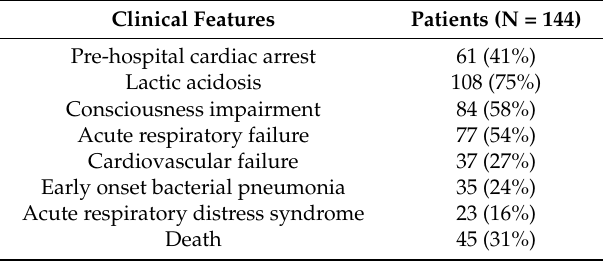
Table 1. Major features and complications presented by the near-drowning patients (N = 144).